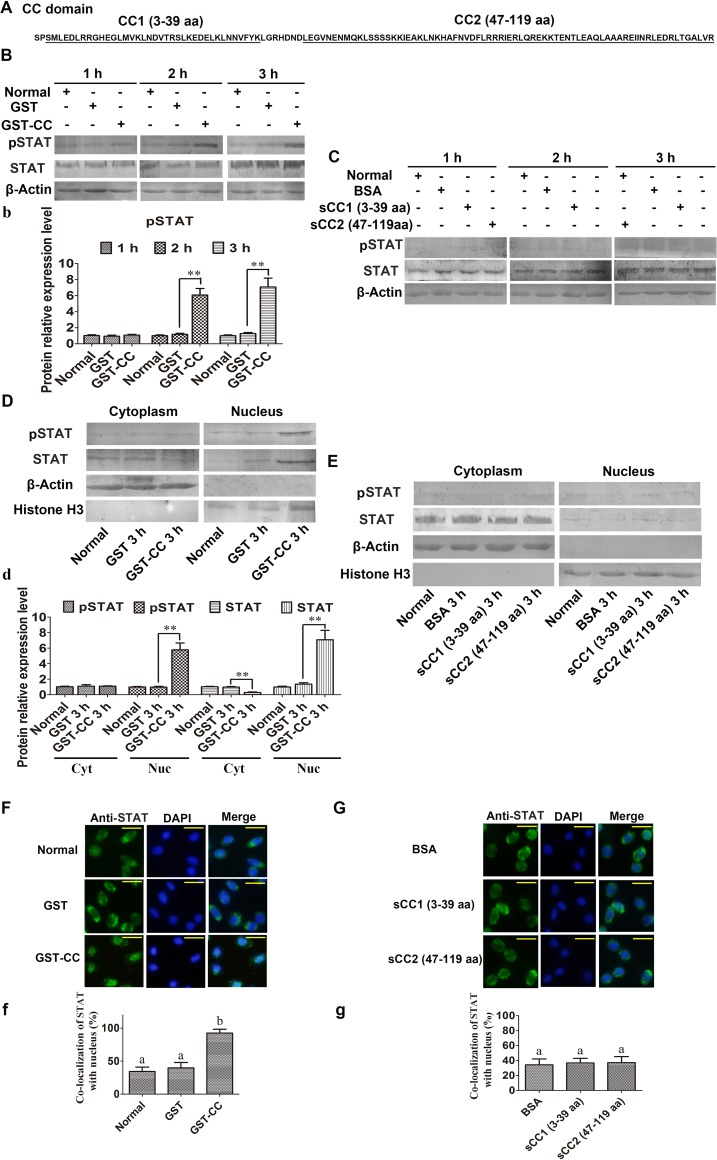
The CC domain of MjCC-CL activates the JAK/STAT pathway.(A) The sequence of CCD from MjCC-CL. (B-C) STAT phosphorylation in GST-CC-, sCC1 (3–39 aa)- and sCC2 (47–119 aa)-injected shrimp at 1, 2 and 3 h was determined by western blotting. (b) Statistic analysis of pSTAT with WCIF ImageJ software. (D-E) The subcellular distribution of STAT and STAT phosphorylation in GST-CC-, sCC (3–39 aa)- and sCC (47–119 aa)-injected shrimp at 3 h was detected by western blotting. BSA injection was used as the control. (d) Statistic analysis of pSTAT and STAT with WCIF ImageJ software. (F-G) STAT translocation in the hemocytes of GST-CC-, sCC (3–39 aa)- and sCC (47–119 aa)-injected shrimp at 3 h was detected using an immunocytochemical assay with a STAT-specific antibody. (f-g) Statistical analysis of F and G: the localization of STAT within the nucleus was analyzed using WCIF ImageJ software. Different letters indicate significant differences (p < 0.05) in one-way ANOVA analysis.